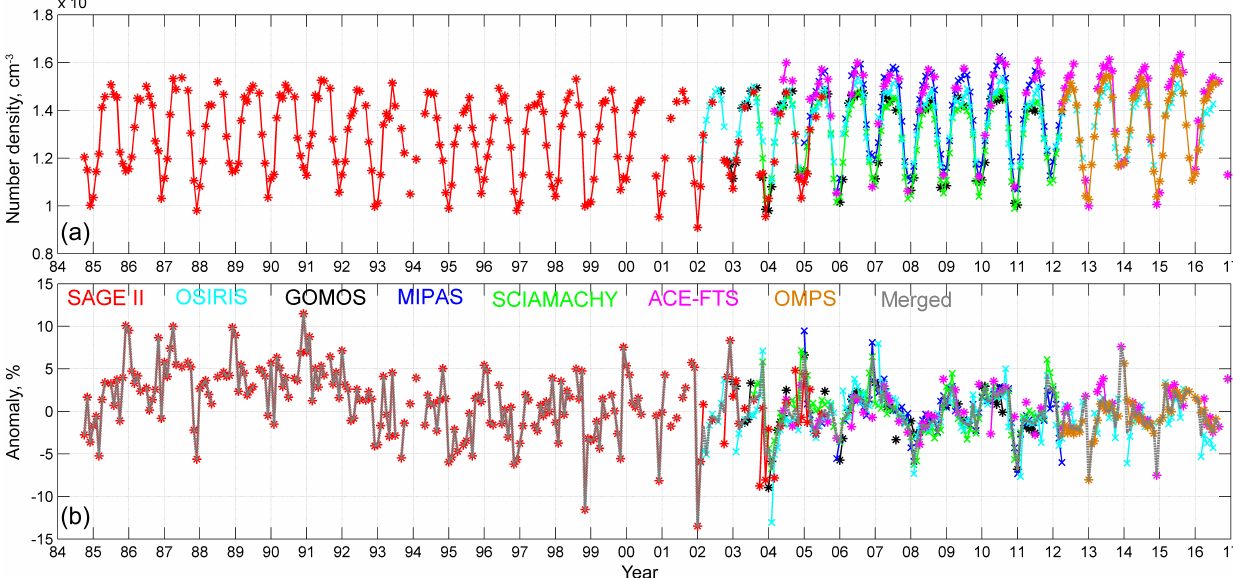
Figure 6. (a) Monthly zonal mean ozone at 35km in the latitude band 40–50 ◦ N. (b) Individual deseasonalized anomalies and the merged anomaly (grey line).